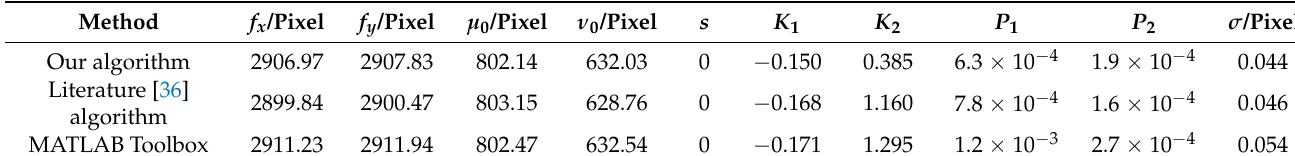
Table 3. Camera calibration results.